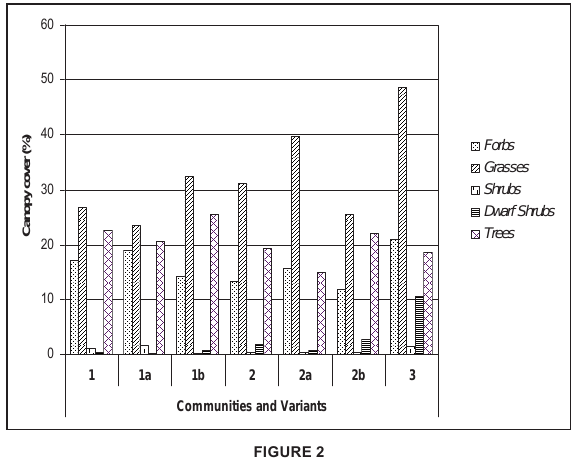
two variants (Table 1). The identified plant communities were as follows: